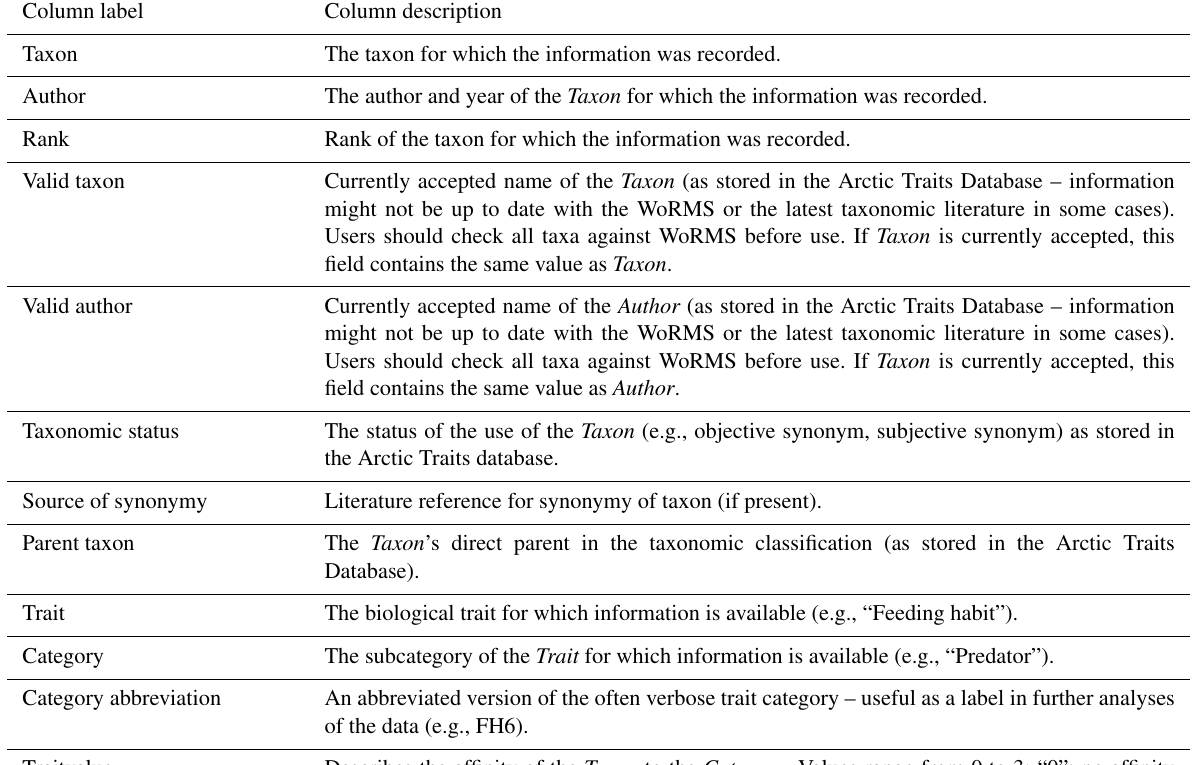
Table 7. List of fields returned by the Arctic Traits Database when “Data as columns” (*.csv) is chosen as an export option from the download